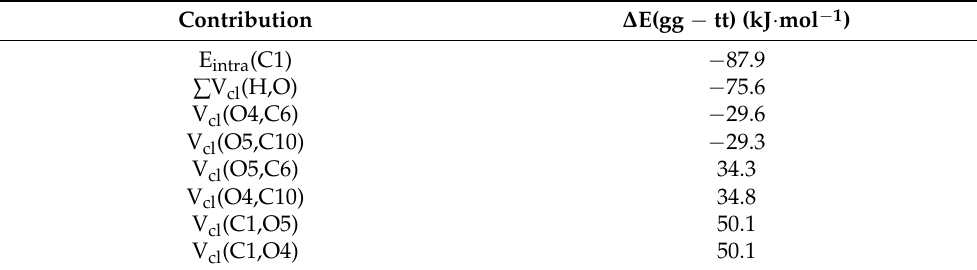
Table 2. A few of the largest-magnitude IQA energy differences between gg and tt.